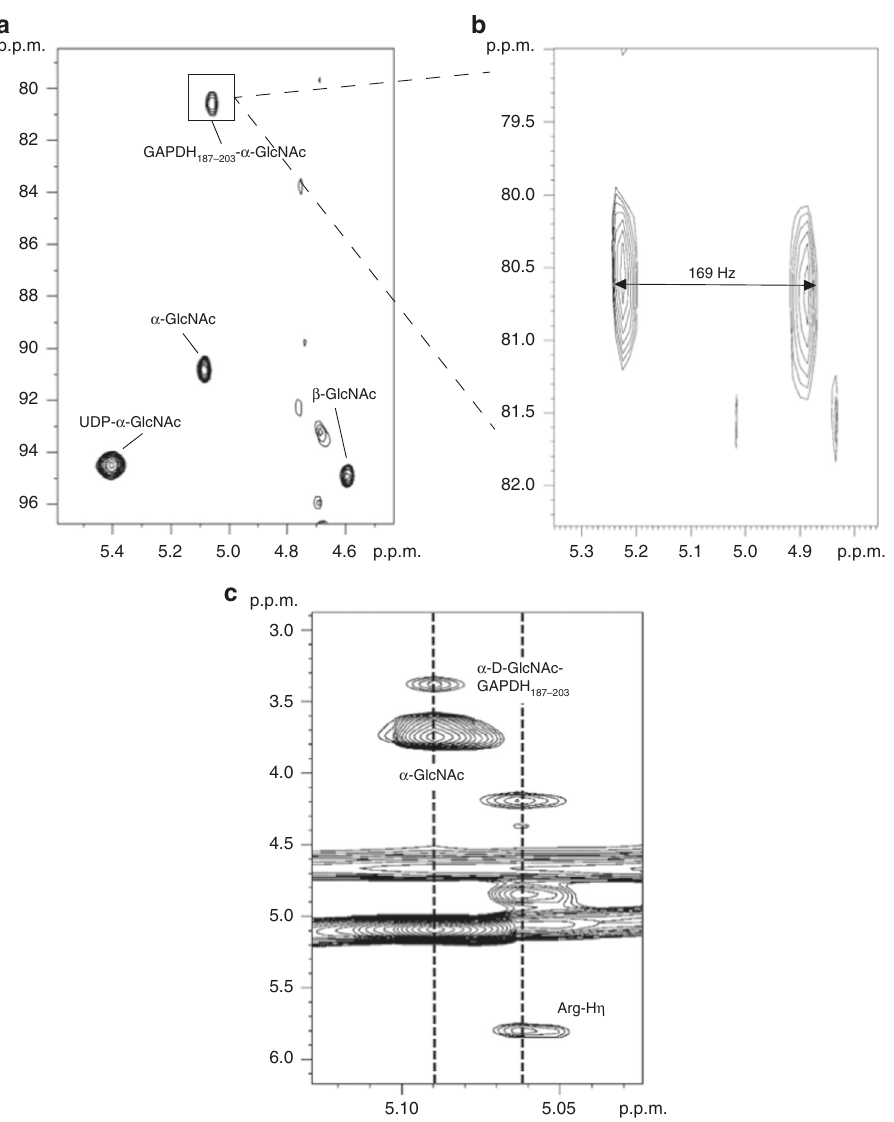
Fig. 1 SseK1 is a retaining-glycosyltransferase. NMR spectra showing the reaction product of GAPDH 195-203 with SseK1. a Decoupled 1 H- 13 C HSQC spectrum (800 MHz) showing the anomeric region, highlighting the presence of α -D-GlcNAc-GAPDH 187-203 , with a large 13 C up fi eld shift relative to the free species. b Expansion of 1 H- 13 C CLIP HSQC spectrum (500MHz) with no decoupling to measure the anomeric 1 J CH coupling in α -GlcNAc-GAPDH 187-203 . A value of 169Hz indicates an α -con fi guration. c 1 H- 1 H TOCSY spectrum highlighting through-bond correlation between the anomeric proton of α -D-GlcNAc in GAPDH 187-203 - α -GlcNAc and an arginine η